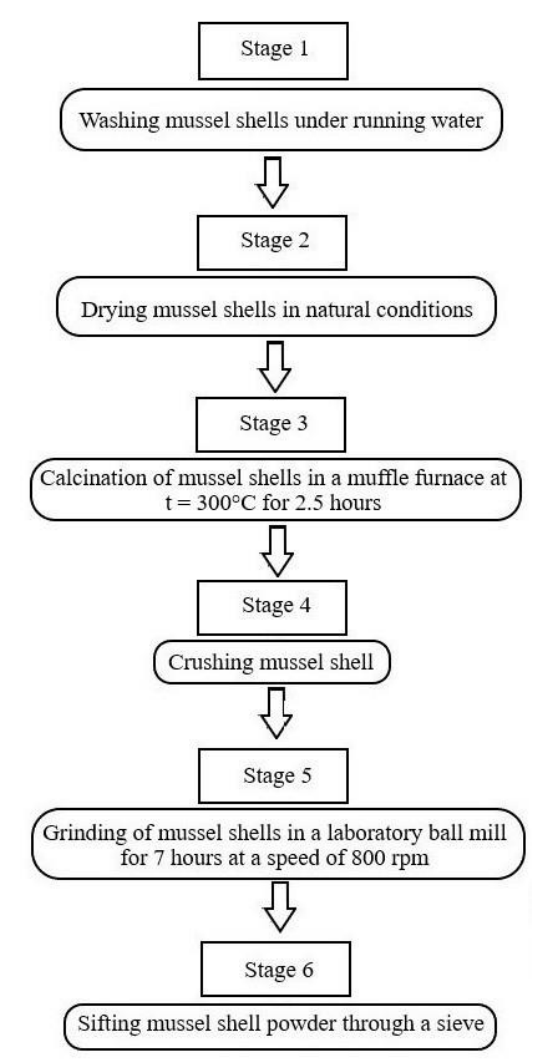
Figure 3. Stages of preparation of powder from mussel shells.